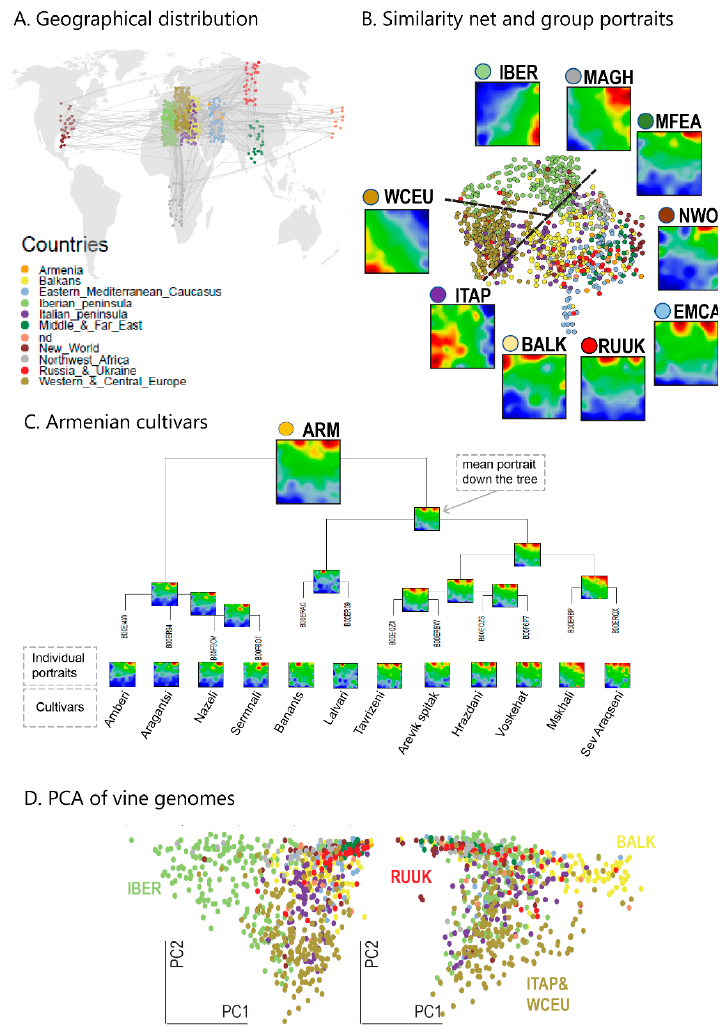
Figure 1. Self-organizing maps (SOM) portrayal of grapevine Single Nucleotide Polymorphism (SNP)-data: ( A ) Sampling of grapevine cultivars from different geographic regions. The thin lines visualize minimum spanning relations between the samples. ( B ) SOM-portraits of cultivars from different geographic regions indicate specific spot patterns of SNPs. The similarity net shows three major clusters of cultivars originating from the Iberian Peninsula (IBER), western and central Europe (WCEU) and Italian Peninsula (ITAP), and the other accessions originating mostly from Eastern Europe, Maghreb, Near East and Middle Asia (see dashed lines). ( C ) Hierarchical clustering tree of the cultivars originated from Armenia. The SOM portraits were progressively averaged in upwards direction. The mean portrait shows the weighted average of the spot patterns of the individual portraits. ( D ) Principal component plots reveal the distribution of accessions from WCEU (and from the Italian peninsula, ITAP) and IBER, along the first two principal components PC1 and PC2, respectively, and the split of the samples from Russia and Ukraine (RUUK) and the Balkan (BALK) along PC3. Color code of samples is provided in part